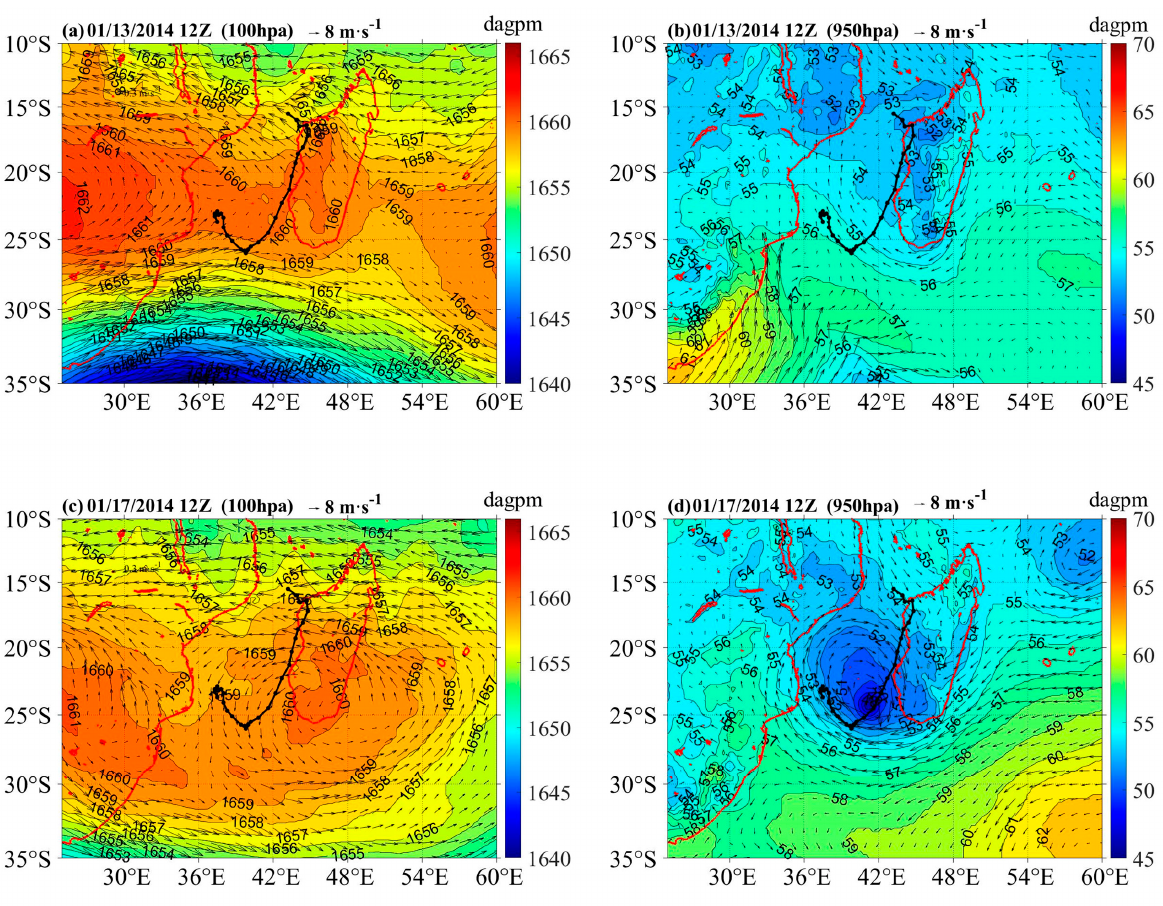
Figure 2. The geopotential height and wind field were distributed at 12Z on 13 January and 17 January 2014. The color bars represent the geopotential height (unit: dagpm, 1 dagpm = 10 gpm), ( a ) and ( c ) show the atmospheric pressure of 100 millibars, and ( b ) and ( d ) show the atmospheric pressure of 950 millibars.